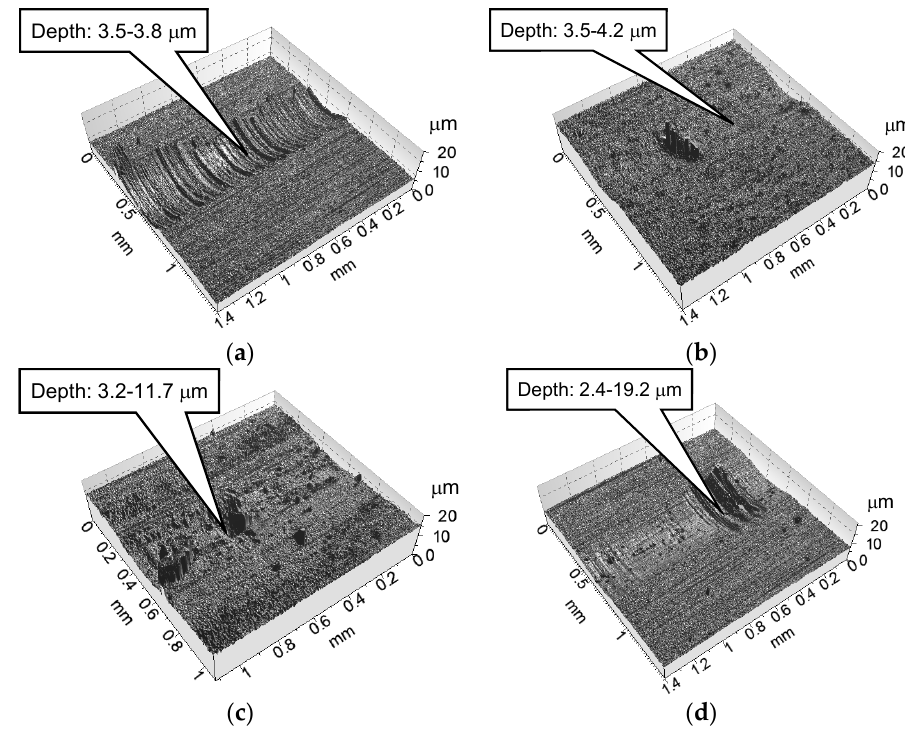
Figure 8. Optical profilometric images of the wear scars on the vee blocks: ( a ) Uncoated vee block lubricated with the mineral oil; ( b ) (W ‐ DLC/CrN) ‐ coated vee block lubricated with the mineral oil; ( c ) (W ‐ DLC/CrN) ‐ coated vee block lubricated with the PAO oil; and ( d ) (W ‐ DLC/CrN) ‐ coated vee block lubricated with the PAG oil.